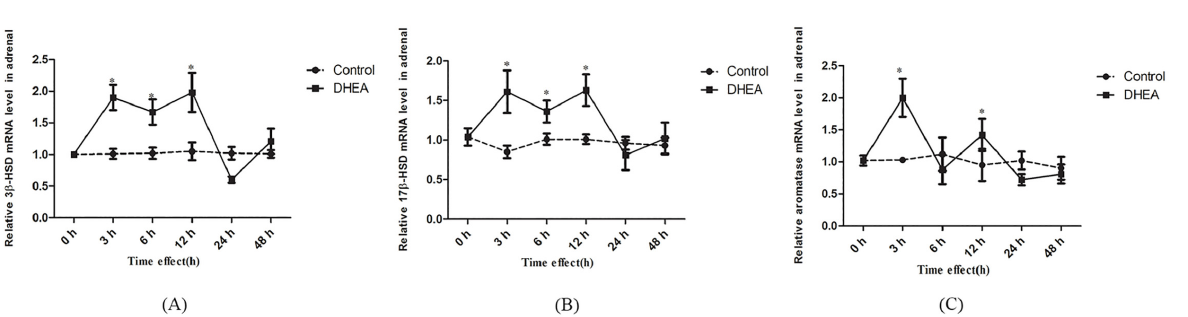
Fig 3. Effect of DHEA on 3 β -HSD (A), 17 β -HSD (B) and aromatase (C) mRNA levels in adrenal in female rat. Data are expressed as means ± SE. ** P < 0 . 01 and * P < 0 . 05 , compared with the respective control group at the same time interval.